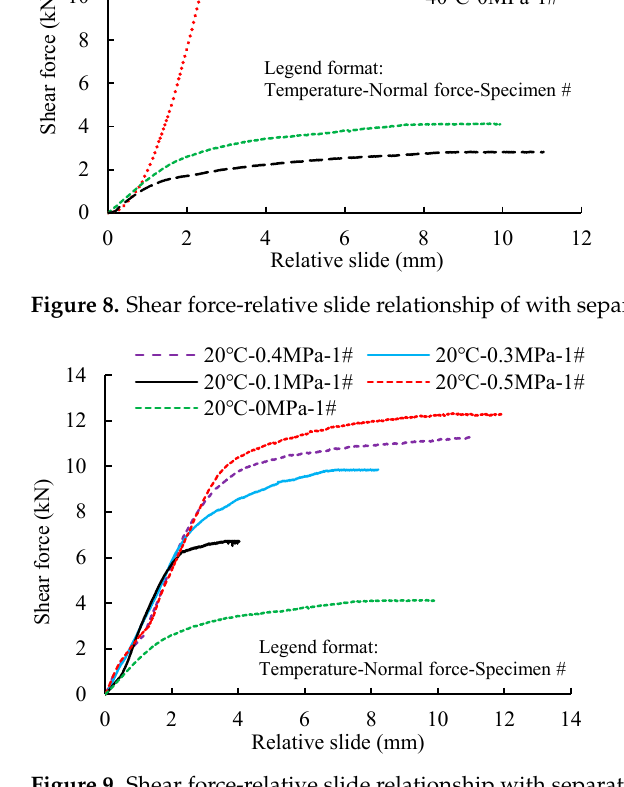
Figure 10. Shear force-relative slide relationship without separator layer.